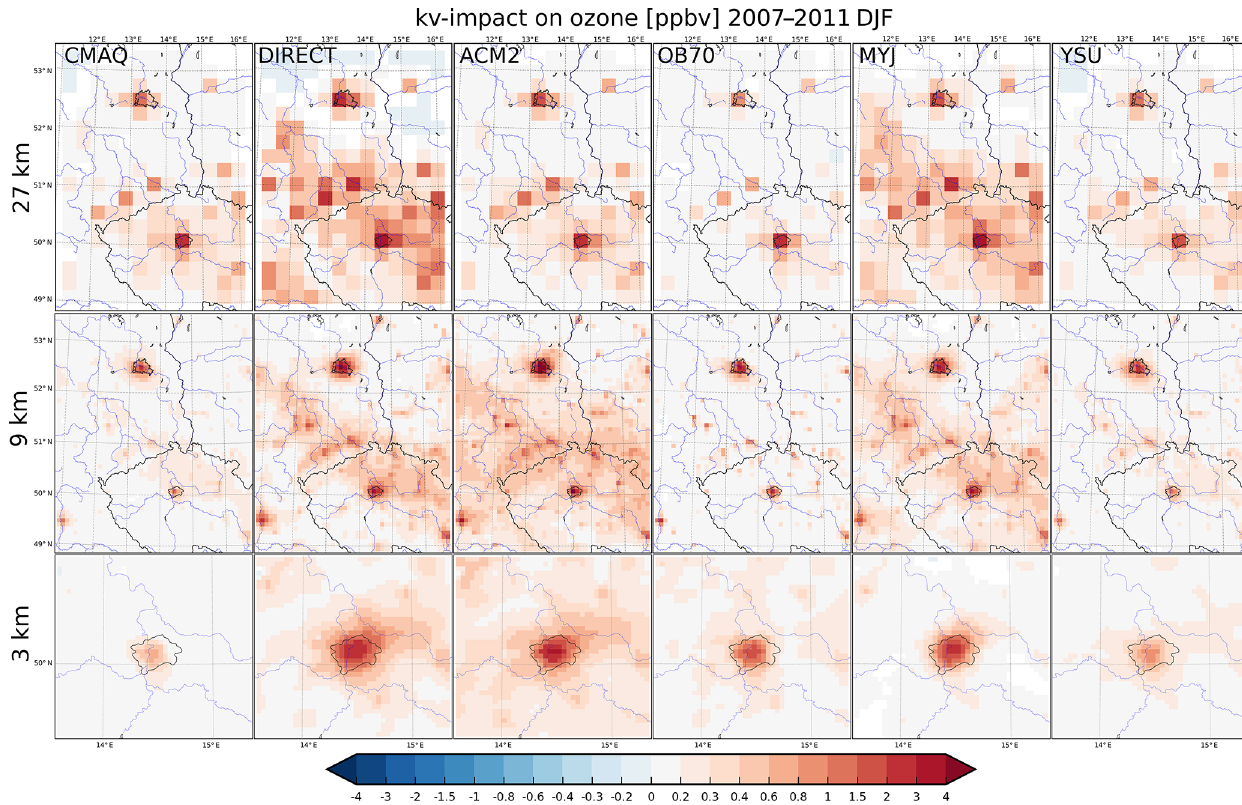
Figure 19. Same as Fig. 18 but for